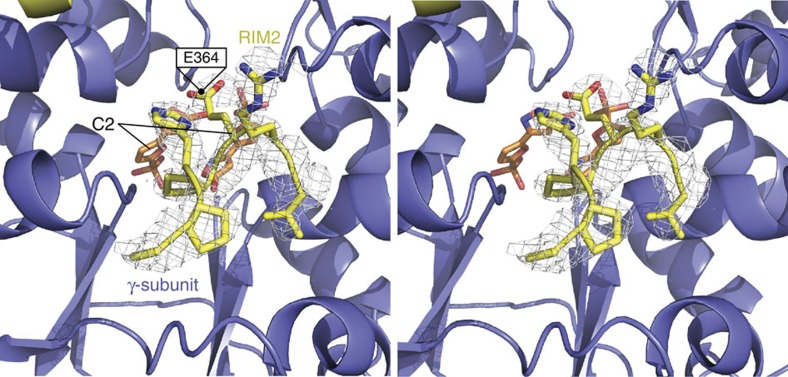
Omit map of the α1RIM2 with C2 bound in the γ-subunit.Stereo 2Fo–Fc omit map of the α1RIM2 (yellow) from the heterotrimeric human AMPK RIM swap chimaera (α2 1-347/α1 349-401/α2 397-end β1γ1) bound to C2, contoured at 1σ. Continuous density (white mesh) can be seen for seven residues of the α1RIM2, including E364 (α2 E368). Weak density for the side-chain carboxyl of E364 suggests some interaction with C2 (orange sticks) bound γ-subunit (blue).